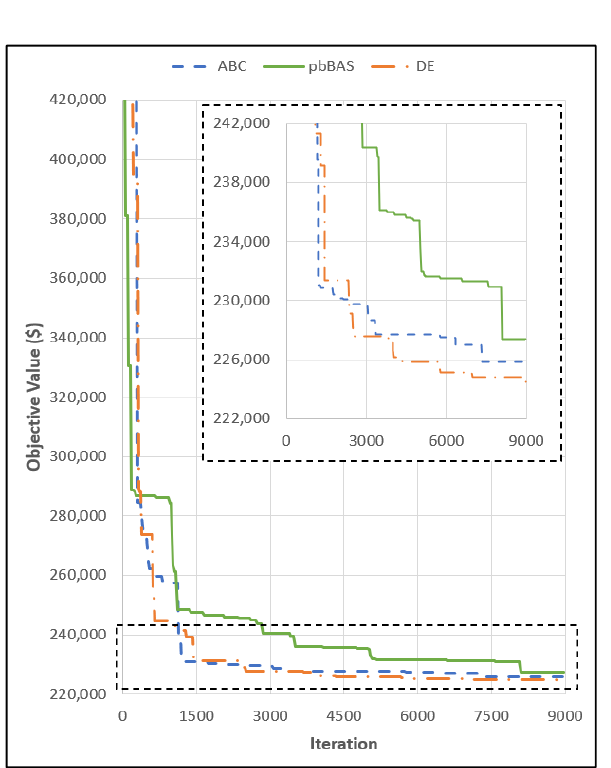
Figure 12. Design history of the best run achieved by each metaheuristic algorithm for the V-type folded plate roof problem.